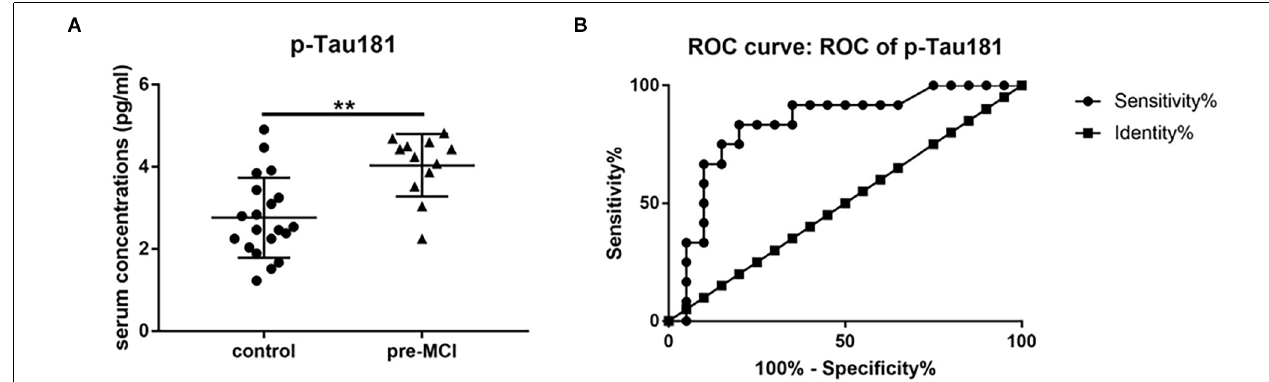
FIGURE 5 | The serum levels and receiver operating characteristics (ROC) analysis of p-Tau181. (A) Serum levels of p-Tau181 in pre-symptomatic mild cognitive impairment (pre-MCI), and controls with black horizontal lines indicating median values. P -values were determined by analysis of variance with Bonferroni post-hoc tests, ** P < 0.01. (B) ROC curve analyses of p-Tau-181 in pre-MCI vs. controls.